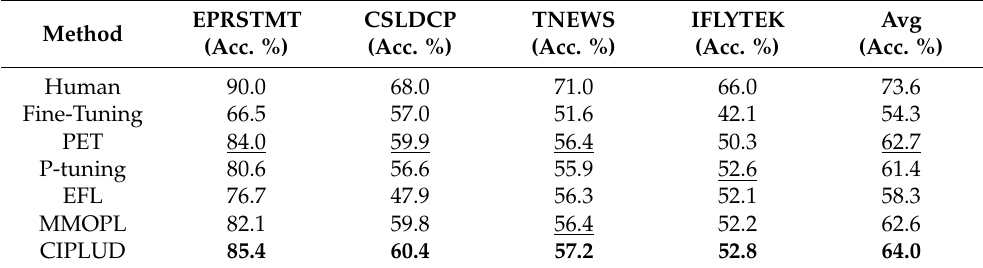
Table 4. The comparison results between our proposed model, CIPLUD, and the baselines. the Human row refers to the performance of human annotators on the tasks, and the underlined values indicate the second-best results achieved among the baseline methods. We bold-marked the highest score in each column.